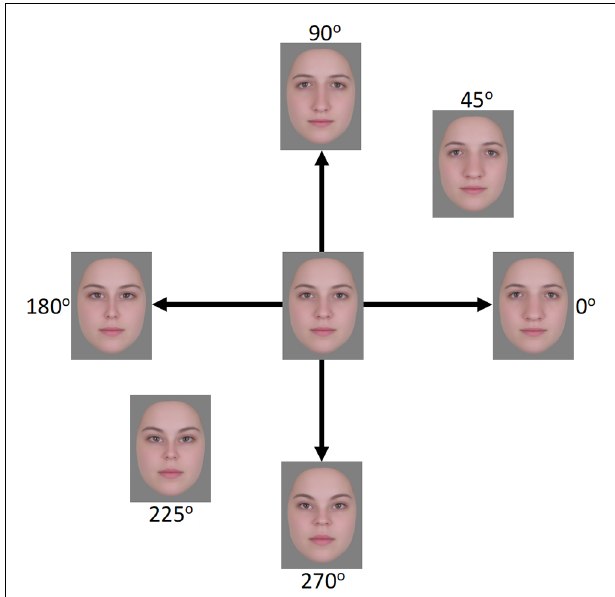
FIGURE 1 | Face images used in the EEG experiment. The horizontal axis (0 ◦ –180 ◦ ) represents expansion/contraction along the horizontal plane of the face while the vertical axis (90 ◦ –270 ◦ ) represents expansion/contraction along the vertical plane of the